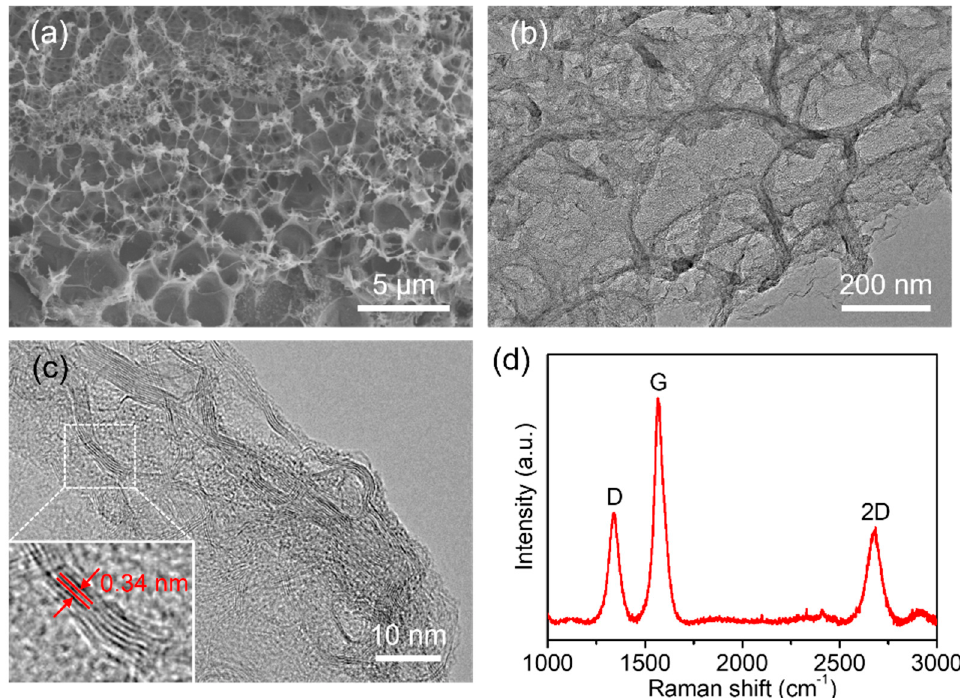
Figure 2. Characterization of 3D graphene networks in-situ grown on PI substrate. ( a ) SEM and ( b ) TEM images showing the 3D network structure. ( c ) HRTEM image indicating the few-layer structure and interplanar distance of graphene. ( d ) Raman spectrum confirming the successful growth of graphene.